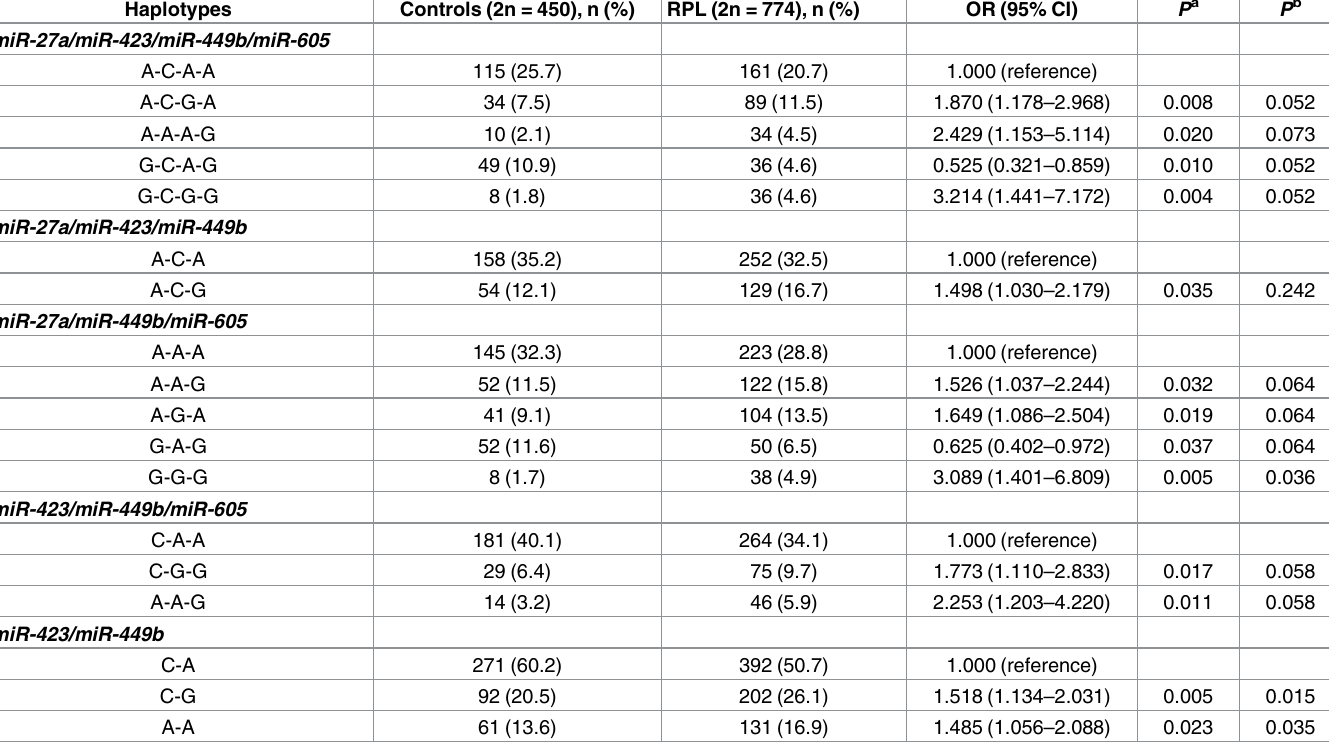
Table 4. Haplotype-based analyses of miR-27a A > G, miR-423 C > A, miR-499b A > G, and miR-605 A > G polymorphisms in Korean RPL patients and control